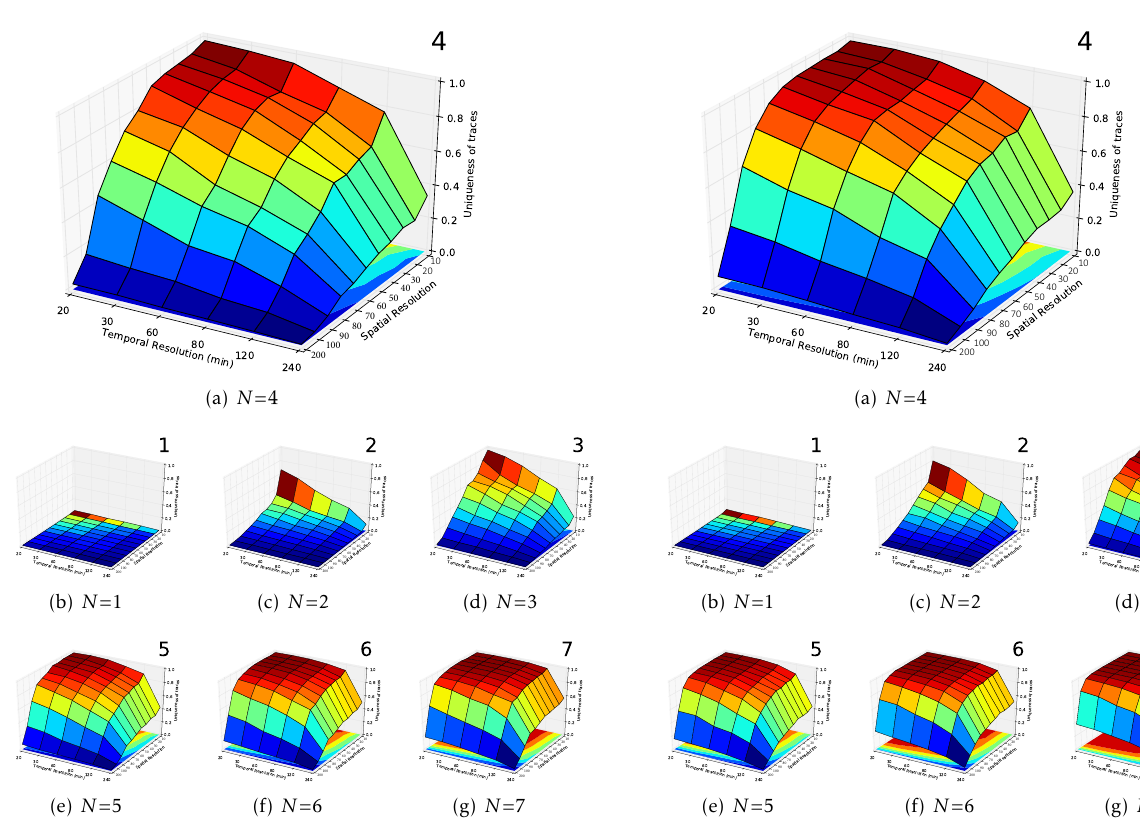
Figure 1. The Result of Shanghai’s Taxis. Figure 2. The Result of Shenzhen’s Taxis.